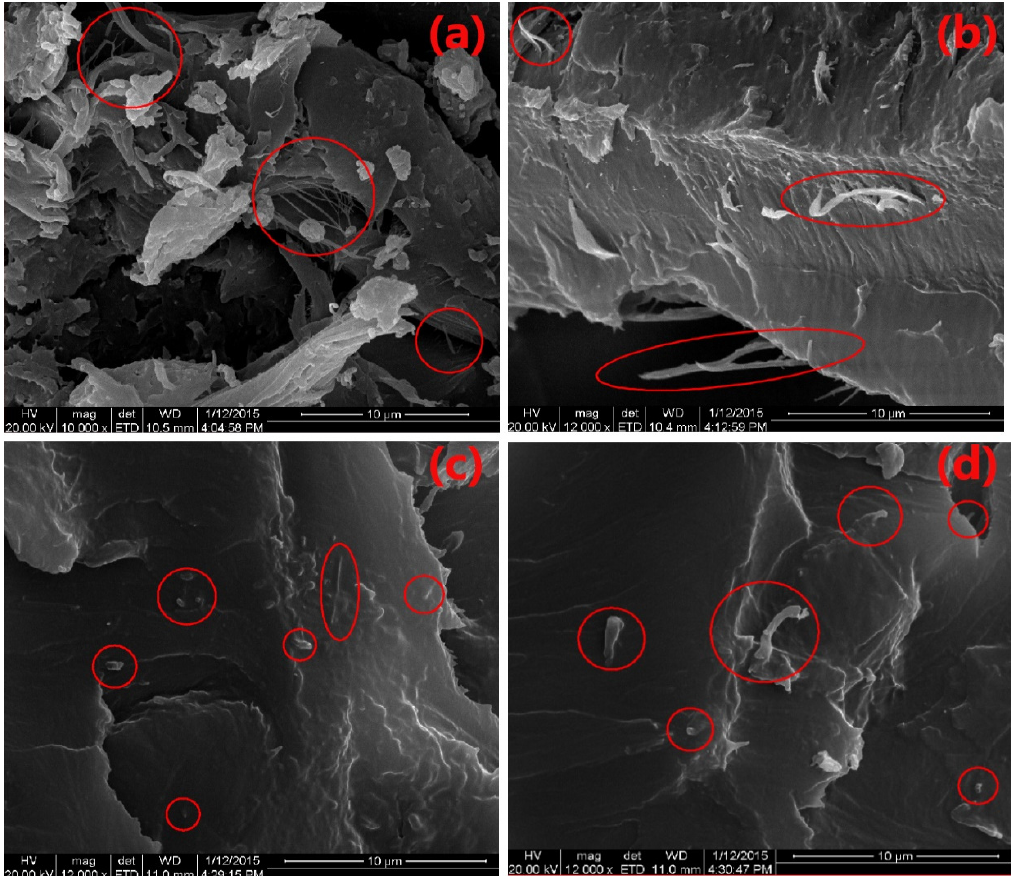
Figure 3. Scanning electron microscopy (SEM) images of nanocellulose crystalline (NCC) on the wood cell ( a , b ) and NCC-WPU ( c , d ).